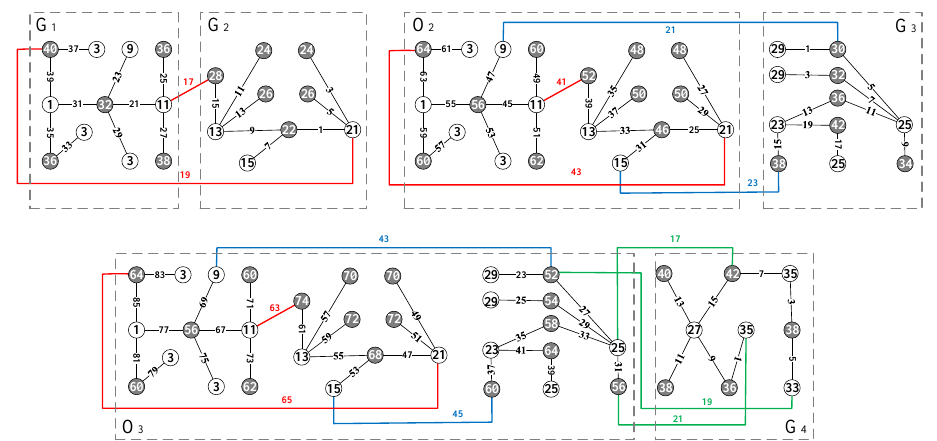
Figure 4. An example for illustrating the proof of Theorem